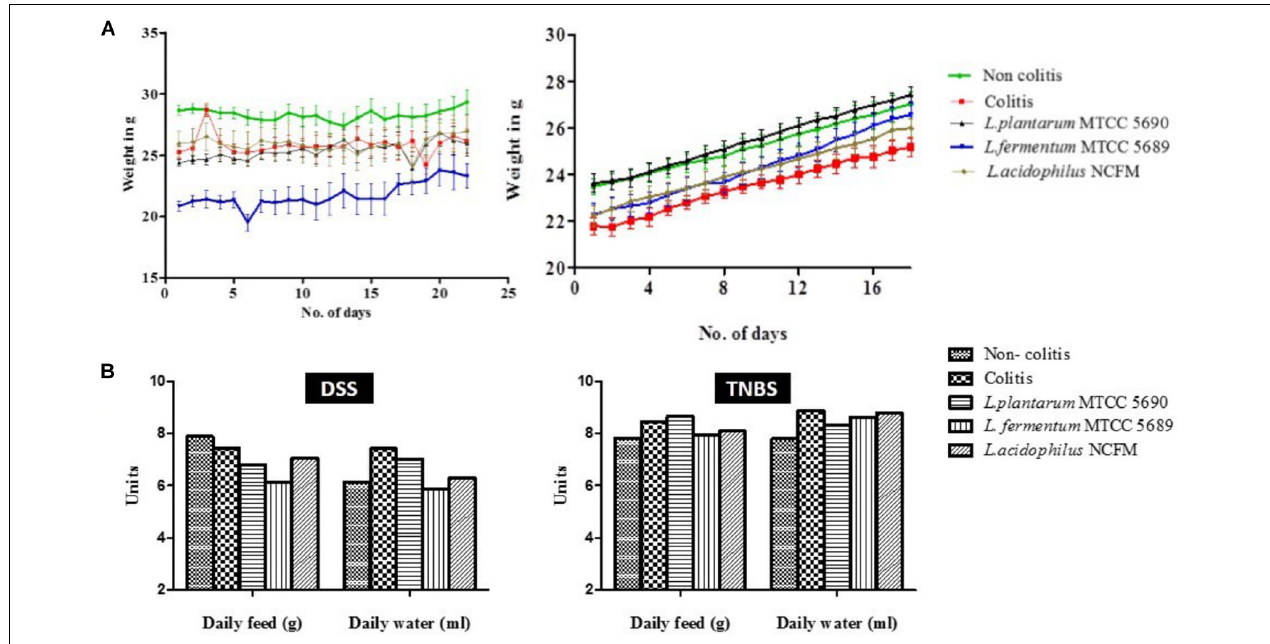
FIGURE 2 | (A) Changes in the body weight of mice throughout the experimental study in both DSS and TNBS induced colitis models; (B) Average feed and water intake of mice from different groups in both DSS and TNBS induced colitis